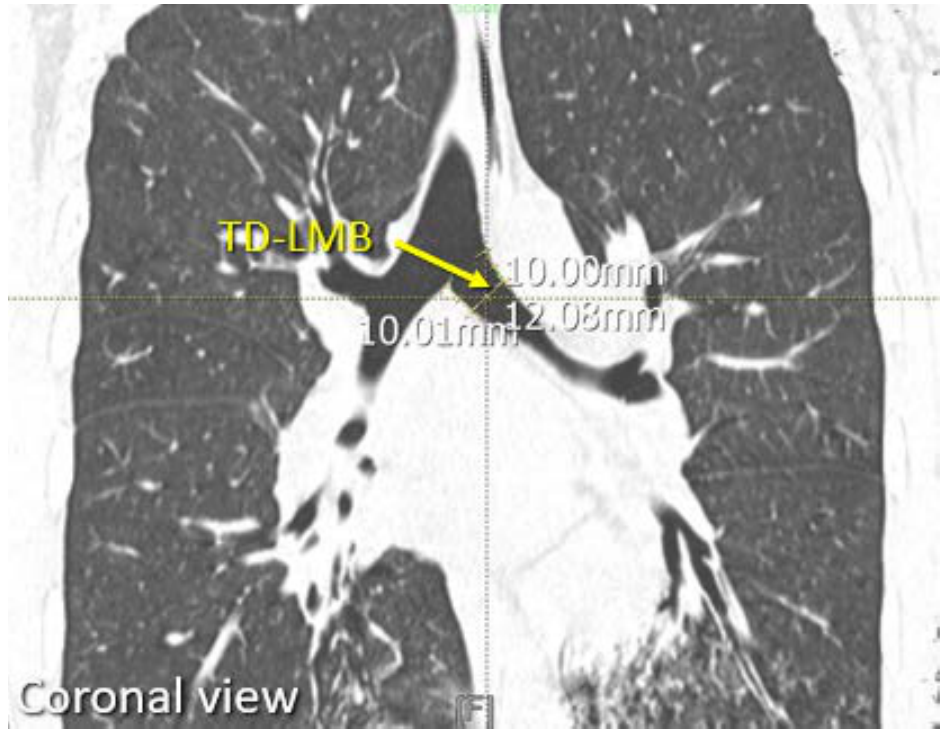
Figure 3. Picture shown measurement of patients’ TD-LMB, performed at 1 cm below carina on chest CT.